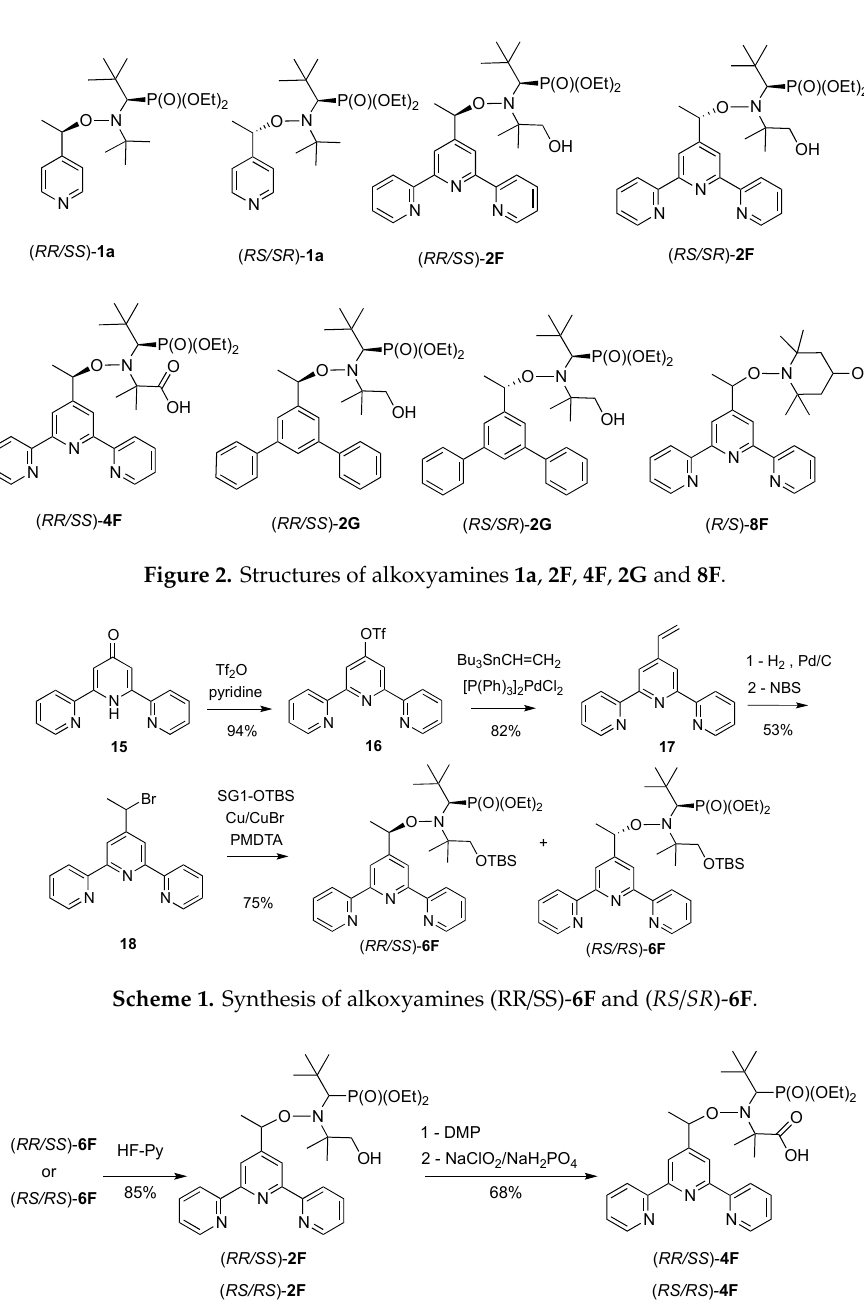
Scheme 2. Synthesis of alkoxyamines ( RR / SS )- 2F , ( RS / SR )- 2F , ( RR / SS )- 4F and ( RS / SR )- 4F .